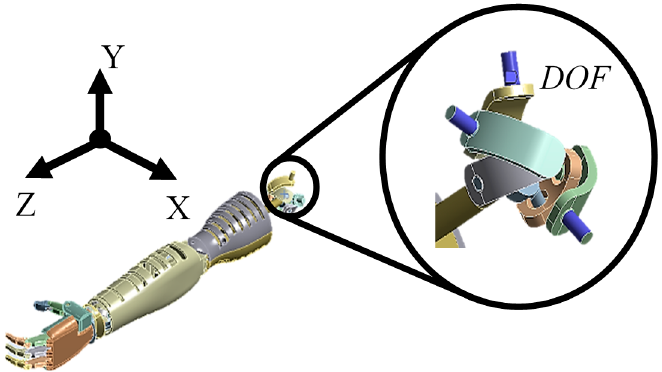
Figure 3. Movement restrictions on top of the spherical shoulder.